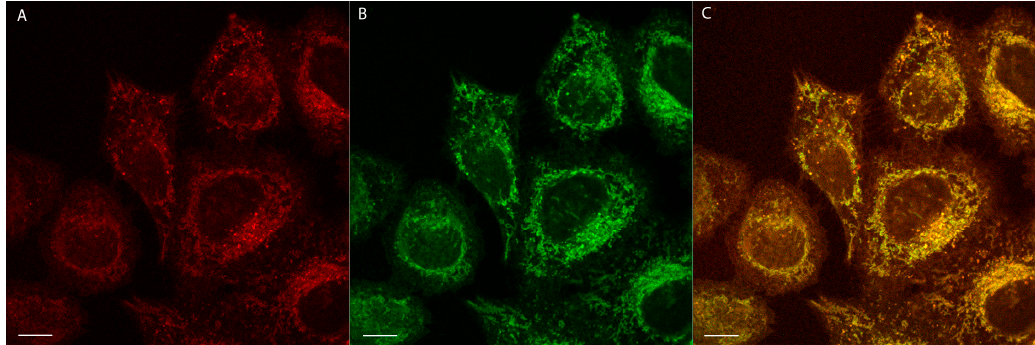
Figure 6. Mitochondria-targeting properties of 2 . ( A ) Co-localization images of HeLa cells stained with 2 (red) and ( B ) mitochondria-specific MitoTracker Green ® (green); ( C ) Merged image of ( A ) and ( B ). Scale bar—10 µm.